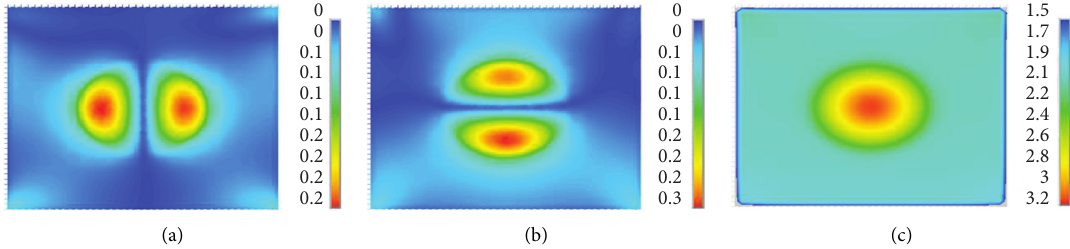
Figure 51: P wave incident (3D sedimentary hemispheric basin, f = 2.0 Hz, R = 100 m, C (a) u x , (b) u y , (c) u z .